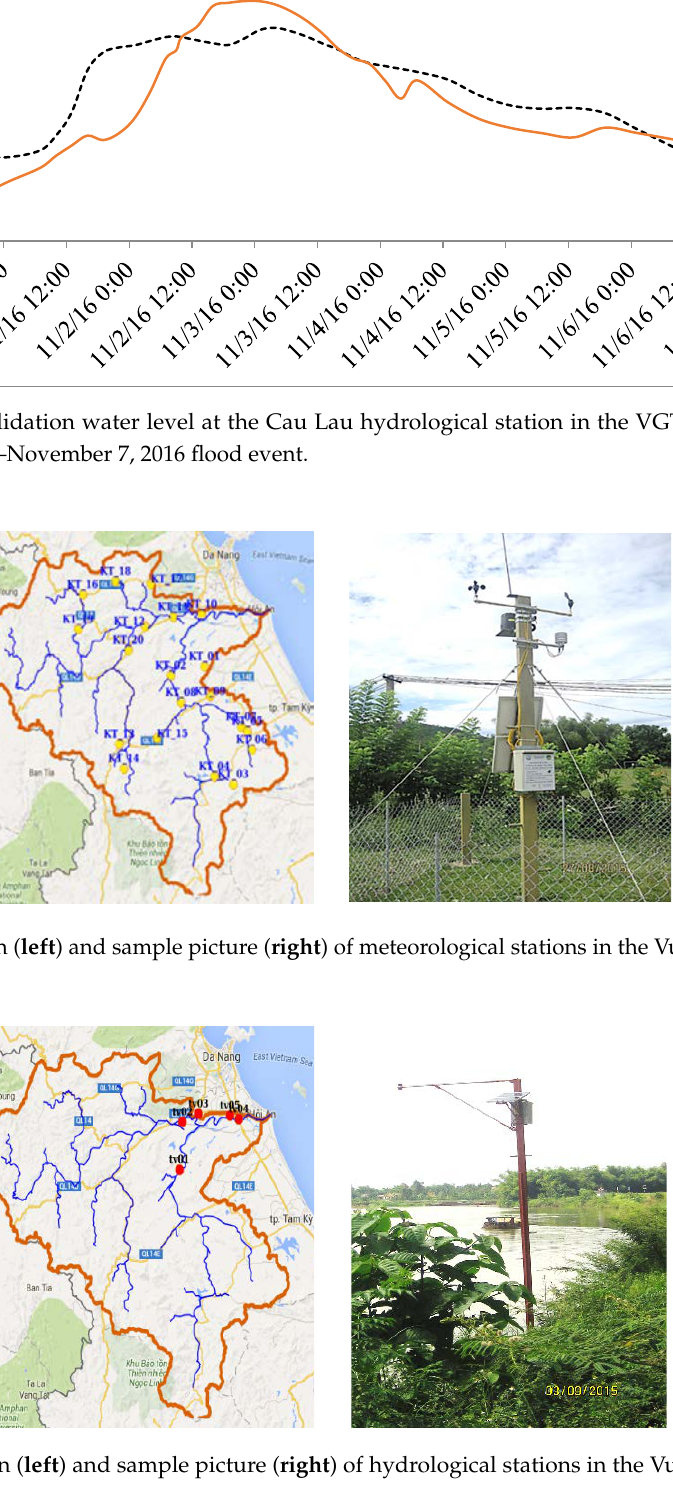
Figure 14. Location ( left ) and sample picture ( right ) of hydrological stations in the Vu Gia-Thu Bon river basin.